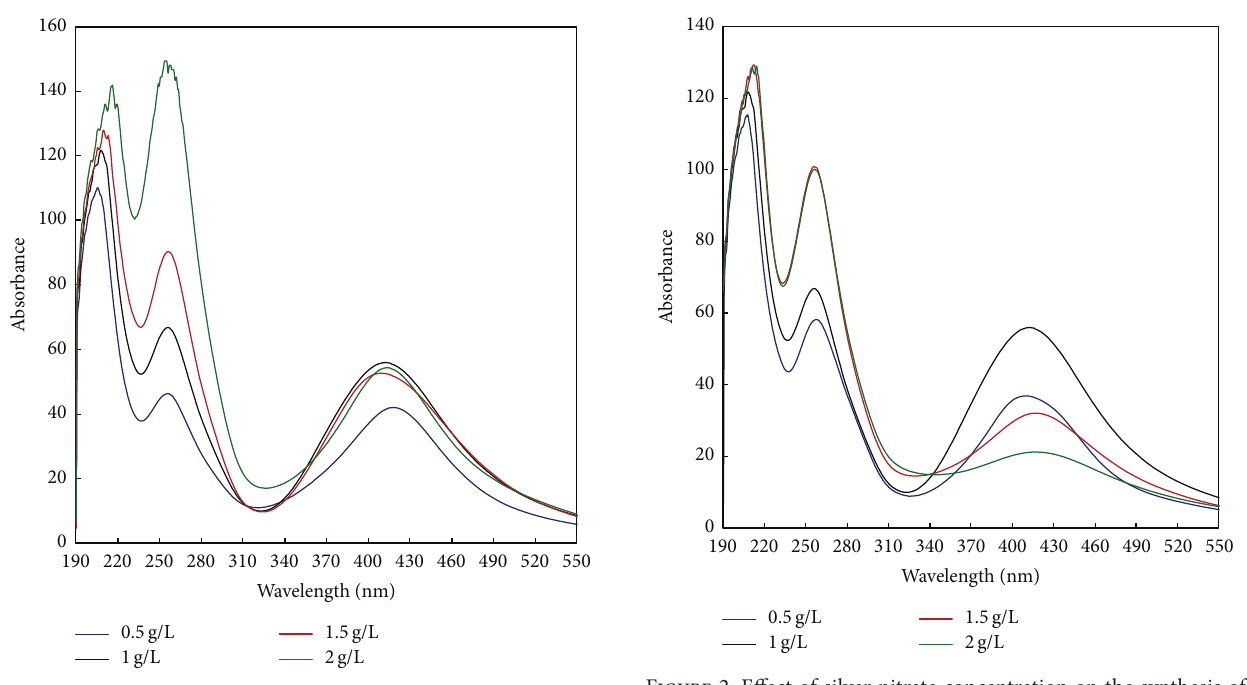
Figure 1: Effect of photoinitiator concentration on the synthesis of silver nanoparticles [CMS], 50 g/L; [PI], 0.5–2 g/L; [AgNO 3 ], 1g/L; temp., 30 ∘ C; time, 60min.; M:L ratio, 1:20; pH, 7.